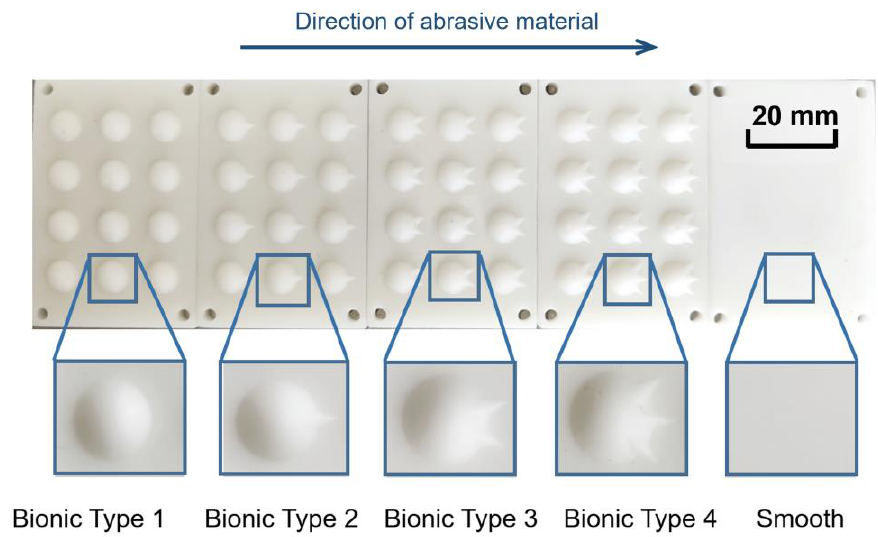
Figure 2. Five types of abrasive wear experimental sample (the direction of abrasive material is from left to right).